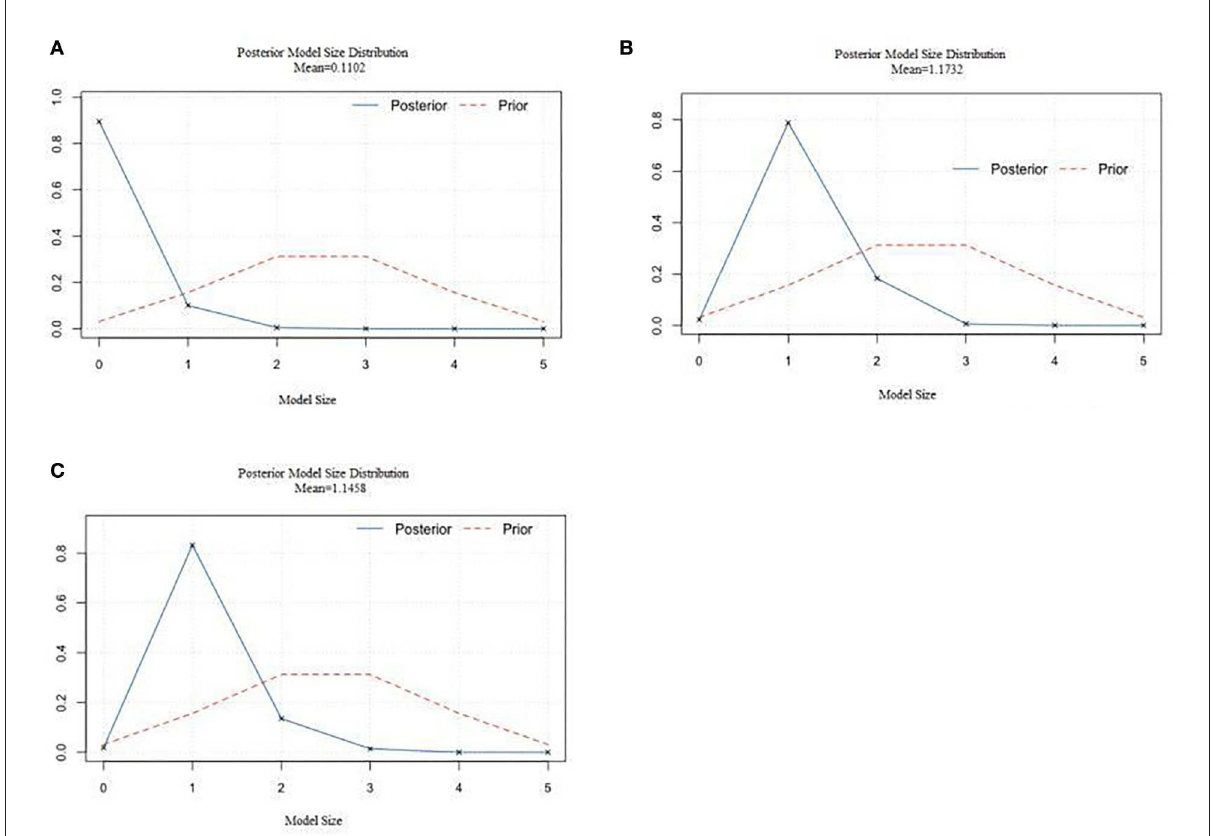
FIGURE2 The mean value of the regular distribution of the posterior model for students. (A) The posterior model size distribution for primary school students. (B) The posterior model size distribution for junior high school students. (C) The posterior model size distribution for senior high school